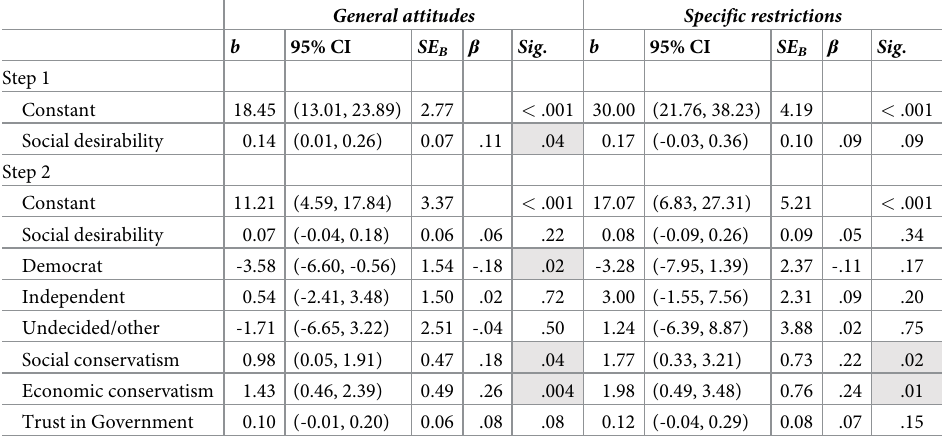
Table 11. Multiple regression for predicting attitudes to easing COVID-19 restrictions for political